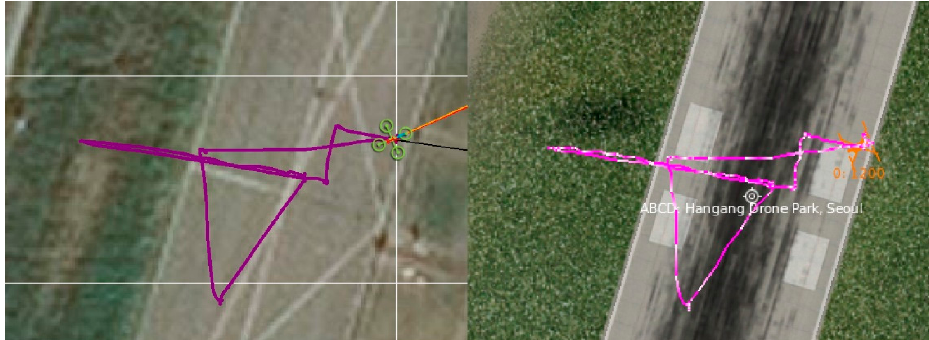
Figure 18. Flight Task 2, flight trajectory of the real ( left ) and the virtual quadcopters ( right ).